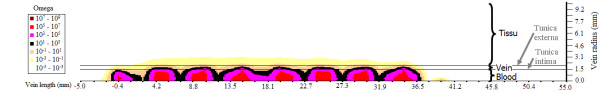
Isodamage distribution inside tissues power: 15 W, pulse: 2s, delay: 2s, pull-back distance: 5 mm; vein diameter: 3 mm, λ = 980 nm).